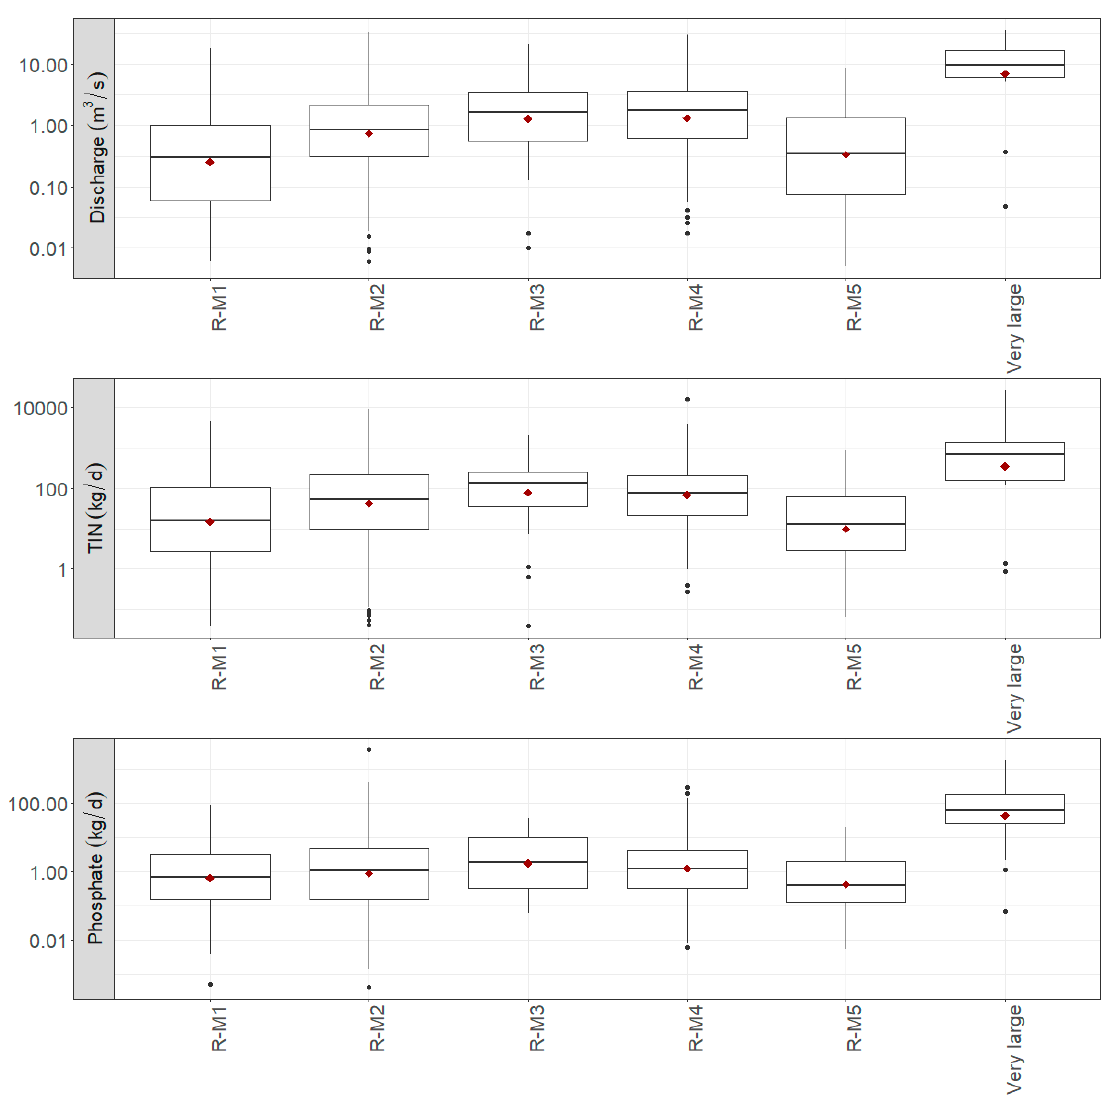
Figure 6. Boxplots of discharge (log. scaled), total inorganic nitrogen load (log. scaled) and inorganic phosphorus load (log. scaled) per river ICT. The red dot indicates the mean value. R-M1 refer to “small Mediterranean streams”, R-M2 to “medium Mediterranean streams”, R-M3 to “large Mediterranean streams, R-M4 to “Mediterranean mountain streams”, R-M5 to “temporary streams” and Very large to “Large rivers” according to the typology for the Mediterranean Intercalibration Group.